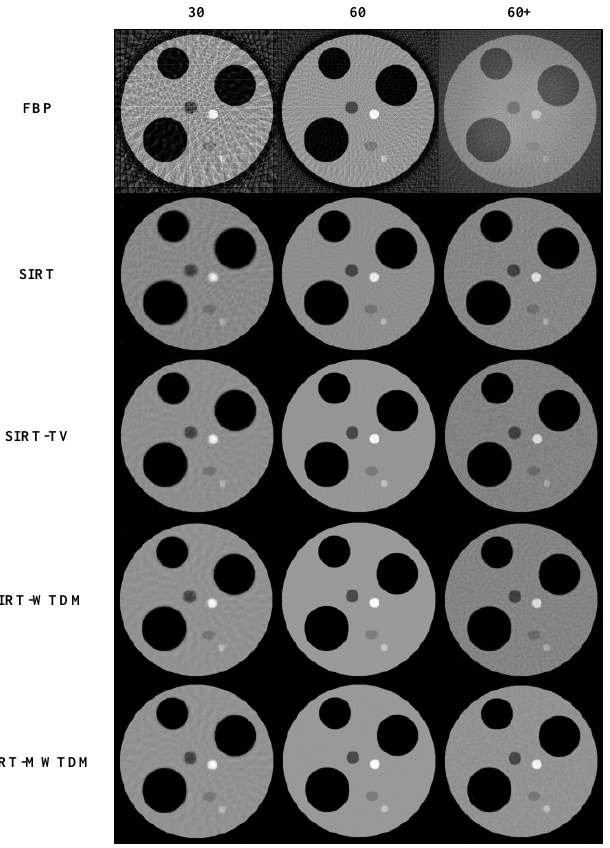
Figure 6. Reconstructed results of the circular phantom obtained by using different algorithms with different numbers of projections. Images from left to right show reconstructed results from 30, 60, and 60+ projections, respectively. Here, 60+ indicates that Poisson noise is added to 60 projections. Rows from top to bottom are reconstructed by using FBP, SIRT, SIRT-TV, SIRT-WTDM, and SIRT-MWTDM, respectively.